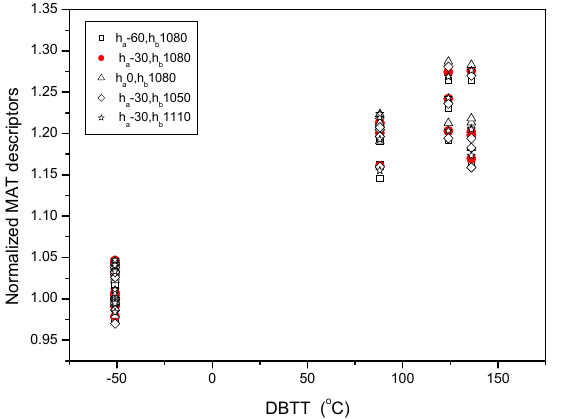
Figure A4. Neighbouring MAT descriptors (black open symbols) around the optimally chosen MAT descriptor (red full circle) as a function of the transition temperature.